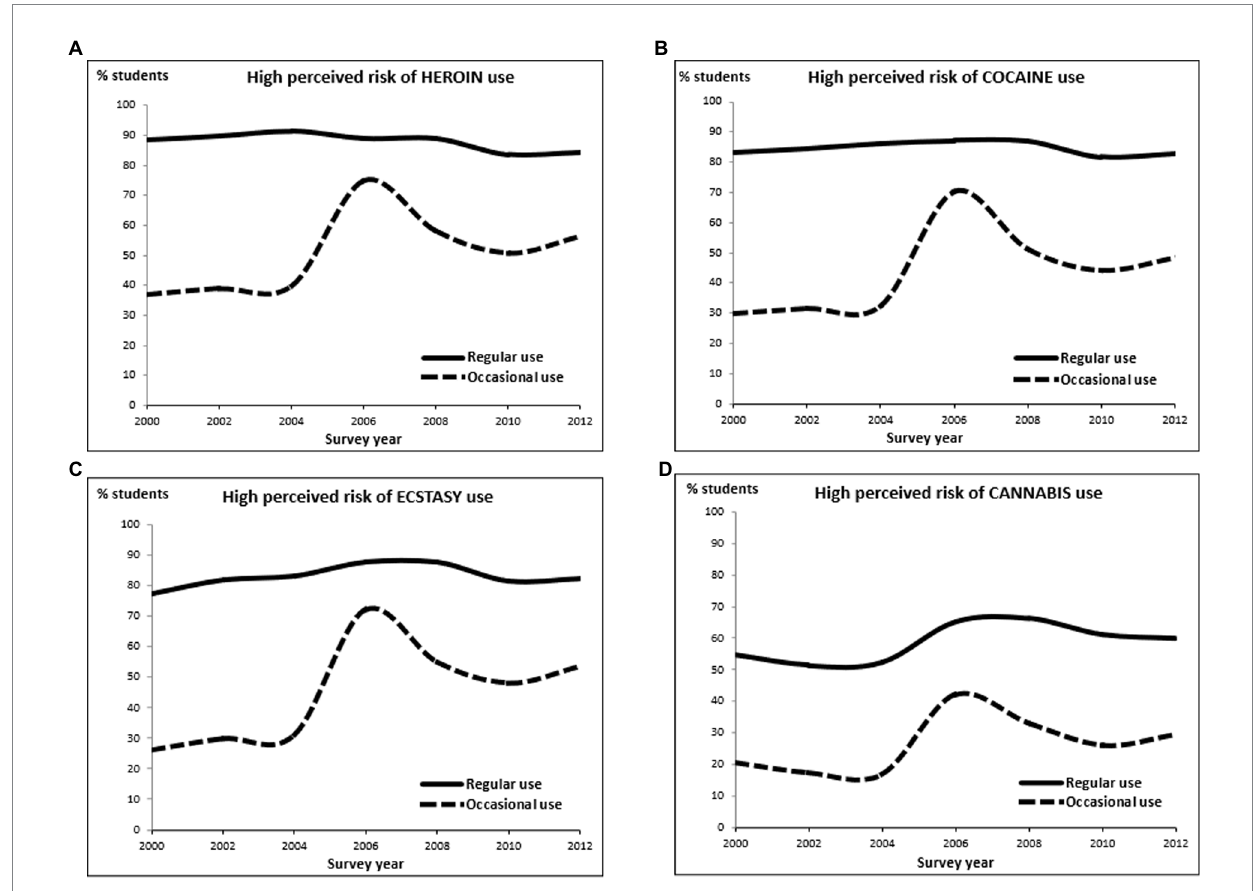
FIGURE 1 Evolution of the prevalence of high perceived risk of regular or occasional use of heroin (A) , cocaine (B) , ecstasy (C) , and cannabis (D) by survey year among secondary students aged 14–18 (%). Spain, 2000–2012. High perceived risk: the student thought that a drug use behavior (for example, using heroin regularly) could cause many problems (in health or other aspects). Regular use: using a drug weekly or more frequently. Occasional use: using a drug monthly or less frequently. The lines are shown smoothed.